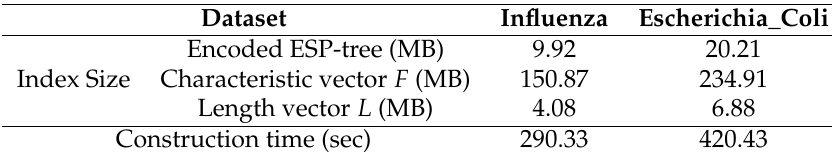
Table 6. Comparison of the index size and construction time for additional datasets.